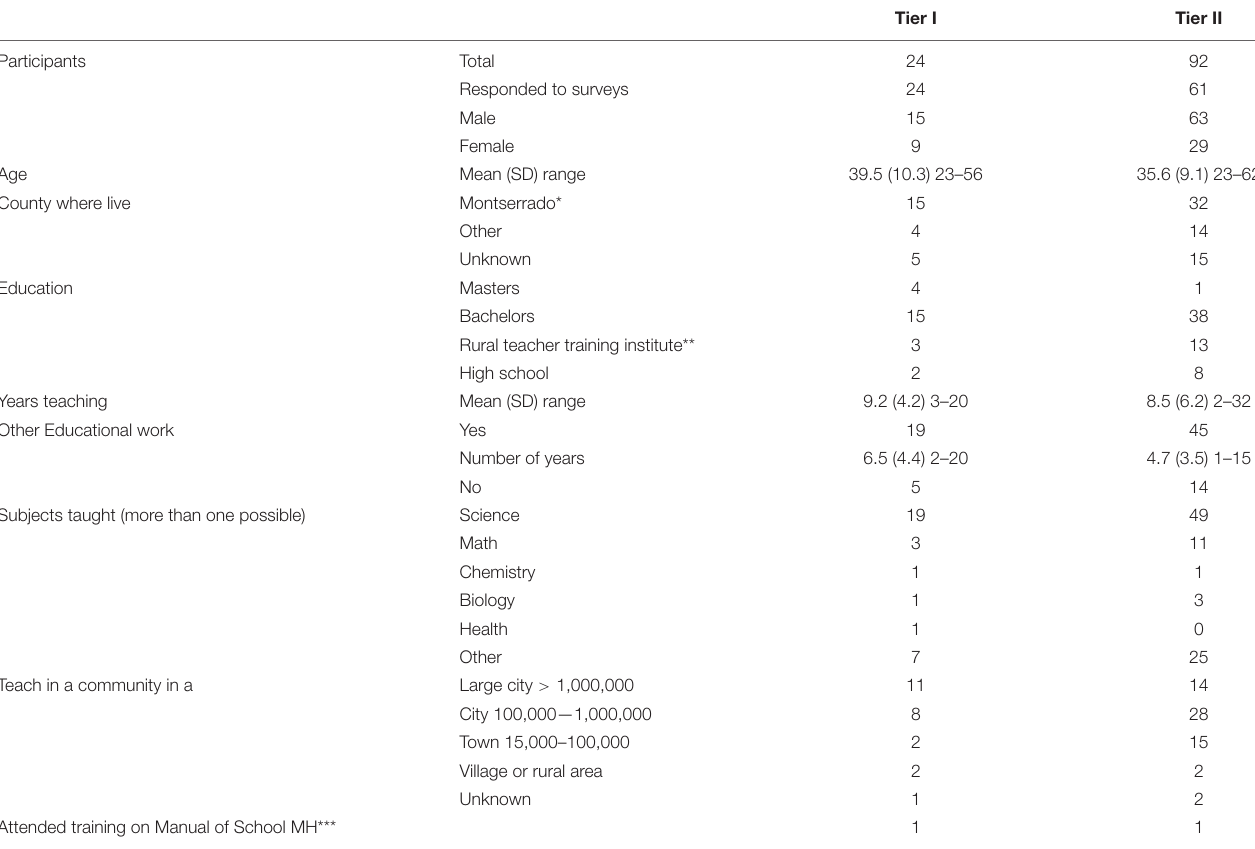
TABLE 1 | Participant